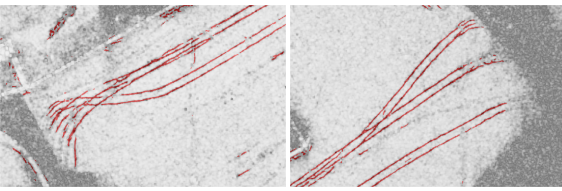
Figure 8. Segmentation results (red) superimposed on the coherence image C 6 , regarding the training with set DS A − E .